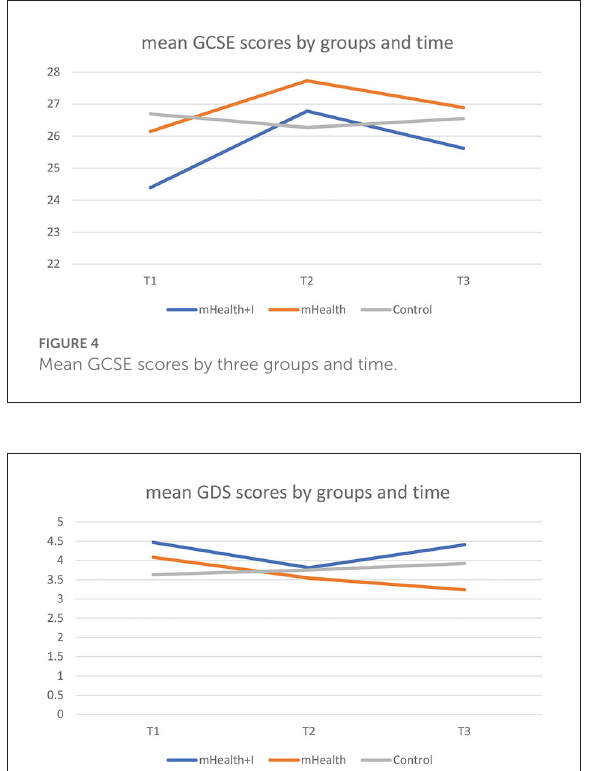
FIGURE5 Mean GDS scores by three groups and